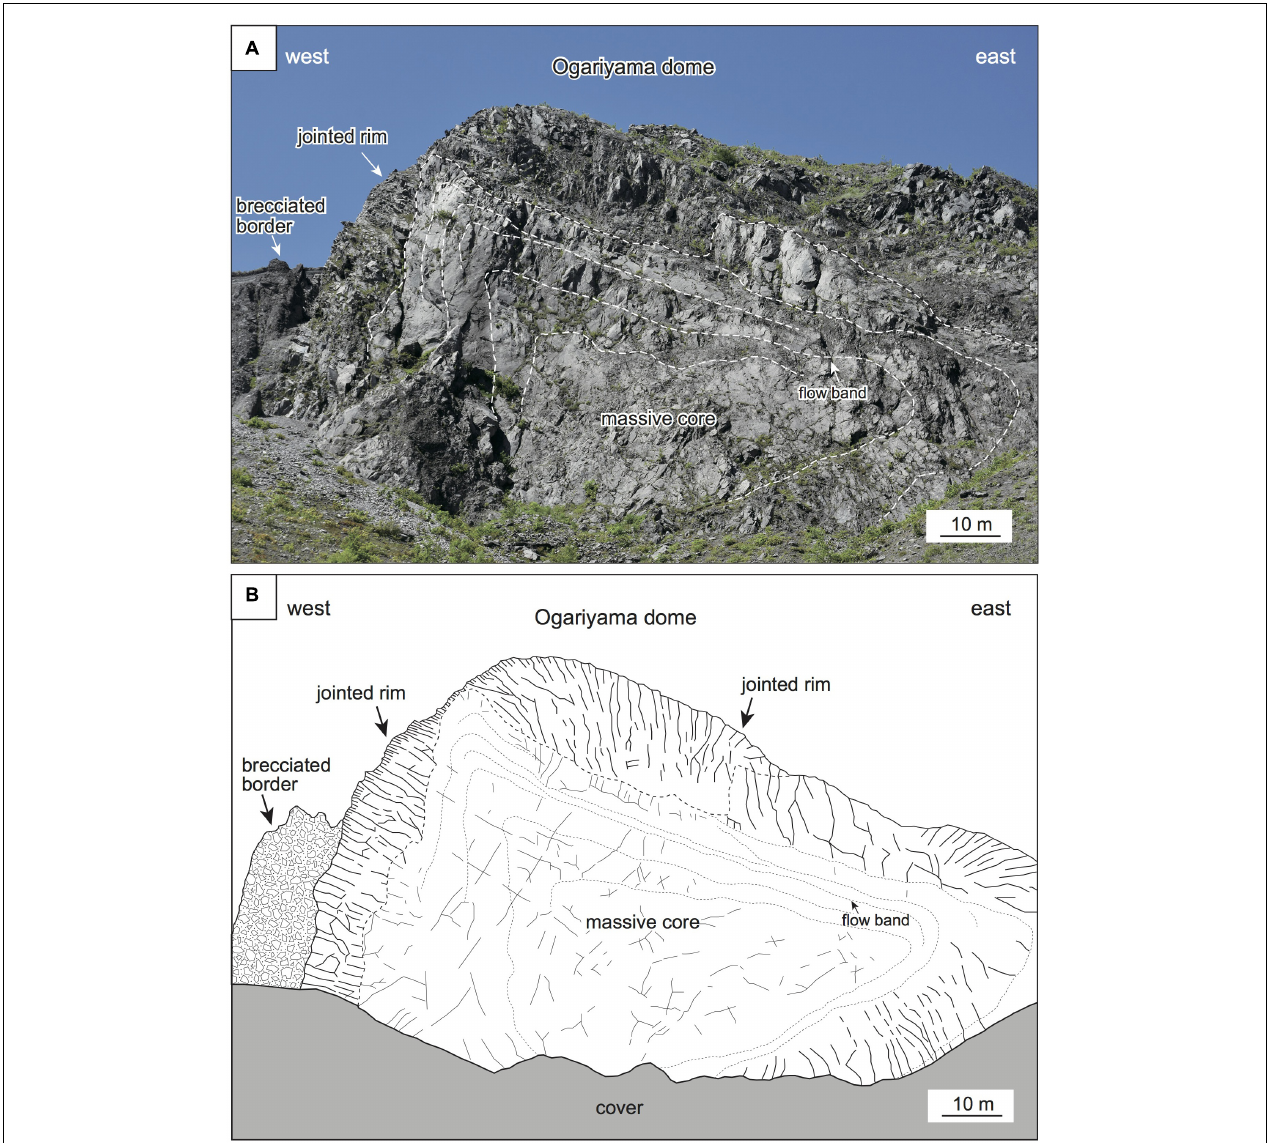
FIGURE 4 | (A) Photograph of a cross-section of the Ogariyama dome, viewed from the south. This cross-section is exposed on a fault scarp that formed in response to growth of the Usu-Shinzan cryptodome. A sketch of this outcrop is shown in (B) . The photograph was taken in 2018. (B) Sketch of the Ogariyama dome, viewed from the south. The Ogariyama dome has a scalene triangular shape, with rounded corners in cross-section, and is 150 m across and 80 m high. The Ogariyama dome is concentrically zoned, with a massive core, jointed rim, and brecciated border. The massive core comprises coherent rhyodacite that has indistinct, large-scale flow banding and poorly developed rectangular joints that are 50–200 cm apart. The jointed rim is characterized by many rectangular joints and irregular fractures. The brecciated border comprises monolithological breccia.